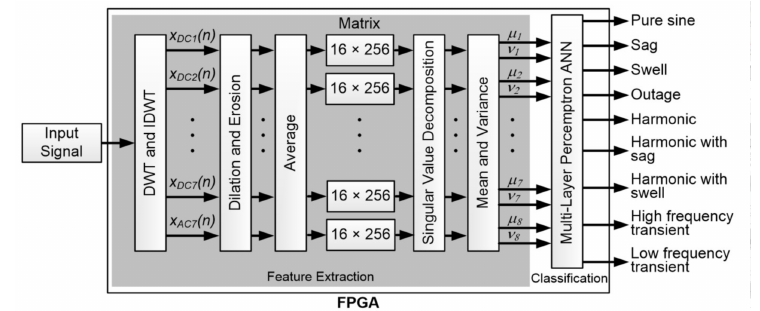
Figure 3. Proposed methodology.